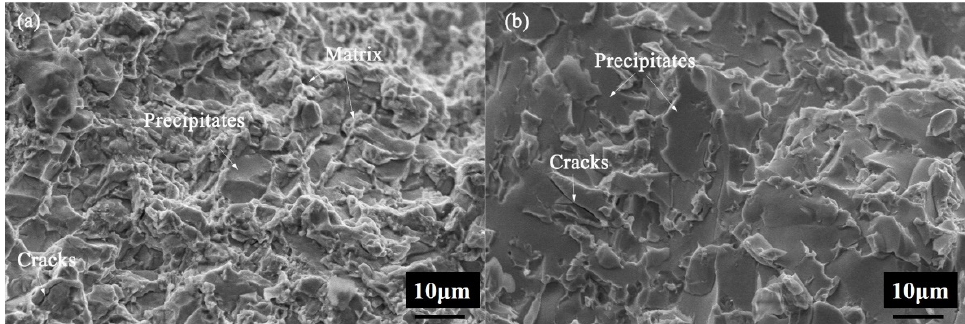
Figure 7. SEM secondary electron images of the fractured surface for ( a ) Mo1 and ( b ) Mo1.5 after compressive tests.